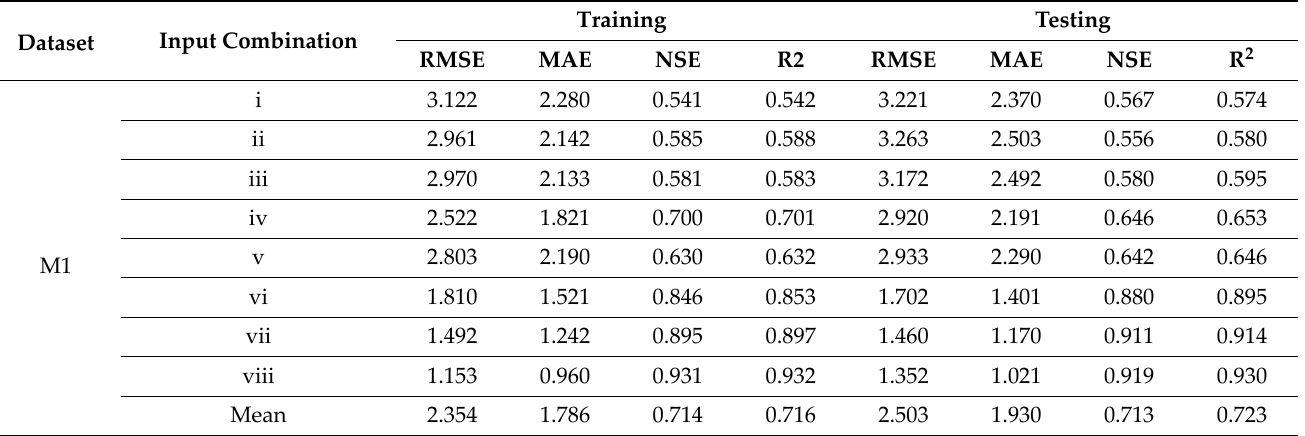
Table 4. The results of the model RVFL‑WCA for monthly time